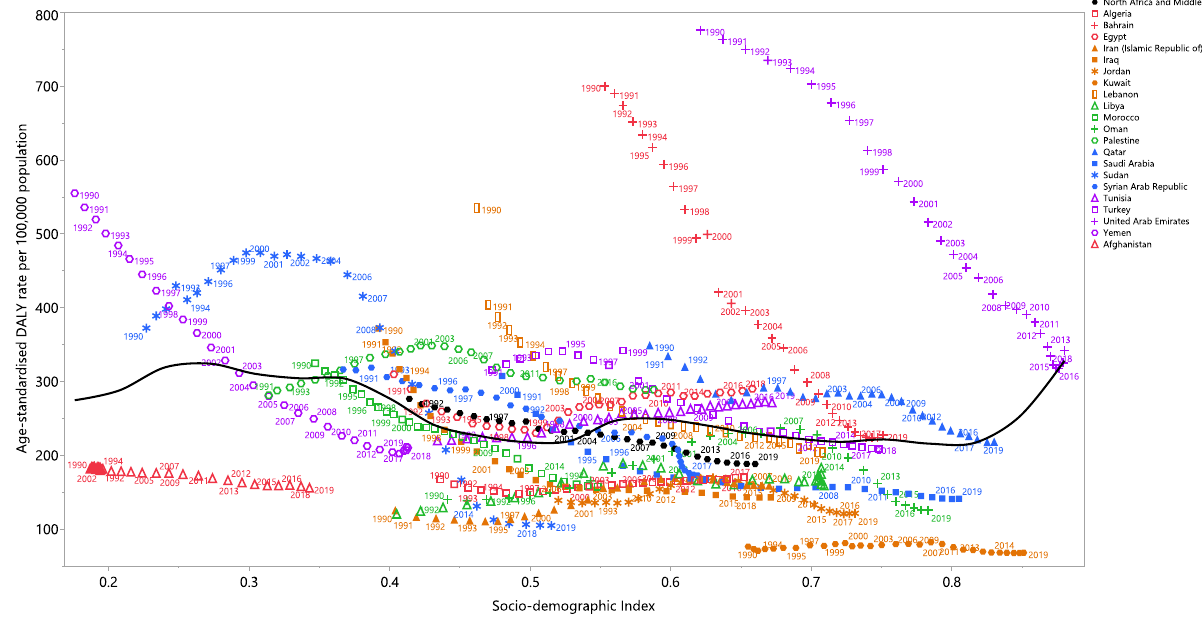
Figure 4. Age-standardised DALY rates of diseases and injuries attributable to alcohol consumption for 21 countries and territories from 1990 to 2019, by SDI; Each point in a line represents the observed age- standardised DALY rate for each year starting at 1990 and ending at 2019. In all countries, SDI has increased over time, so progress in SDI is associated with points further to the right and later years for a given country. Expected values based on the Socio-demographic Index and disease rates in all locations are shown as the black line. DALY disability-adjusted-life-years. SDI Socio-demographic Index (Generated from data available from http:// ghdx. healt hdata. org/ gbd- resul ts-